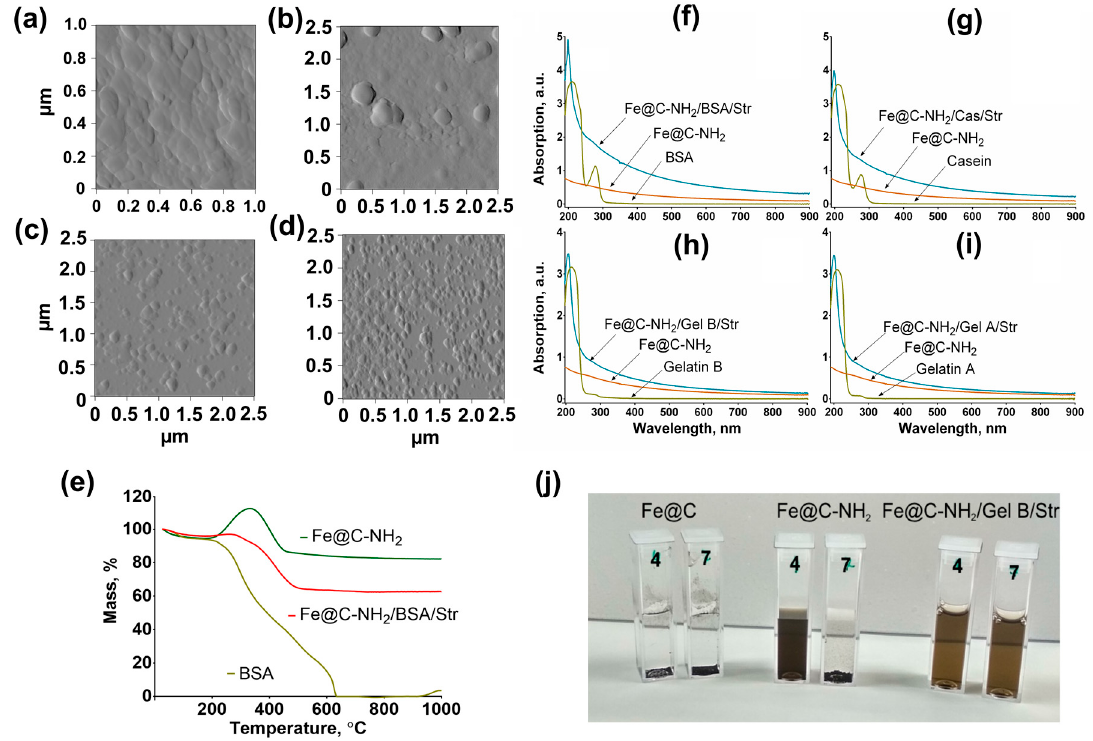
Figure 4. Properties of nanoclusters coated with di ff erent proteins. Upper left: atomic force microscopy (AFM) images of nanoclusters coated with di ff erent proteins: ( a ) BSA, ( b ) casein, ( c ) gelatin A, and ( d ) gelatin B; lower left: ( e ) thermogravimetric analysis (TGA) curves of Fe@C-NH 2 , BSA and Fe@C-NH 2 / BSA / Str in airflow; upper right: UV-Vis spectra of Fe@C-NH 2 , Fe@C-NH 2 / Protein / Str and proteins: ( f ) BSA, ( g ) casein, ( h ) gelatin B, and ( i ) gelatin A; and lower right: ( j ) stability of Fe@C, Fe@C-NH 2 , Fe@C-NH 2 /Gelatin B/Str in buffers with pH 4 and 7.